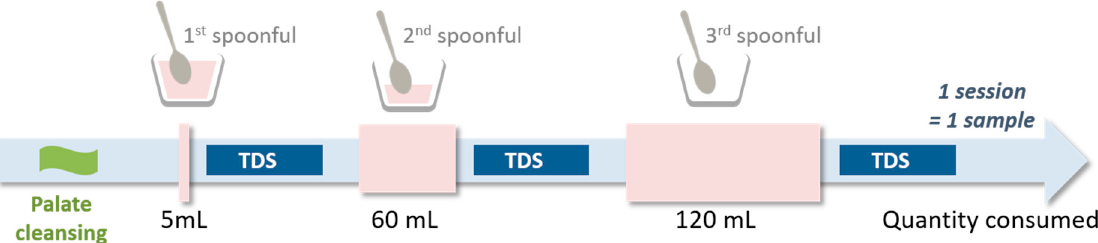
Figure 2. Schematic representation of the multi-intake temporal dominance of sensations (TDS) method used in this